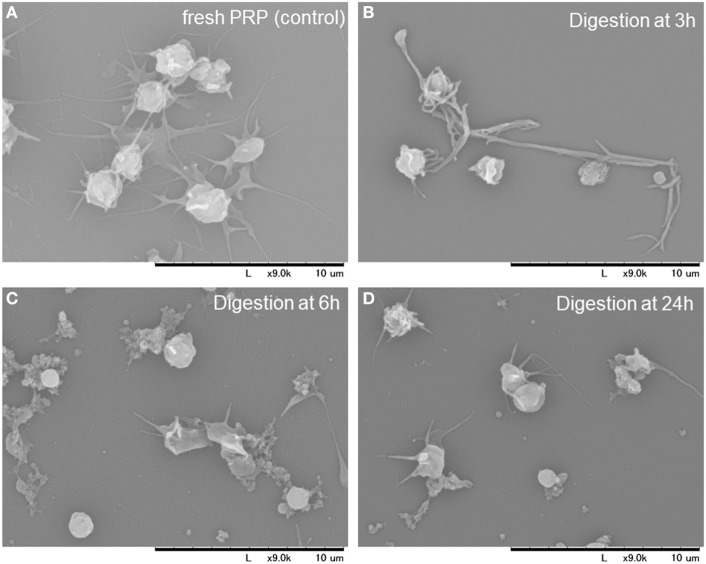
Scanning electron microscopy images of the platelets and other substances present in the digestion mixture at the indicated time points. Platelet-rich plasma (PRP) before clotting (A). PRP-FM digested with tissue-plasminogen activator for 3 h (B), 6 h (C), and 24 h (D).